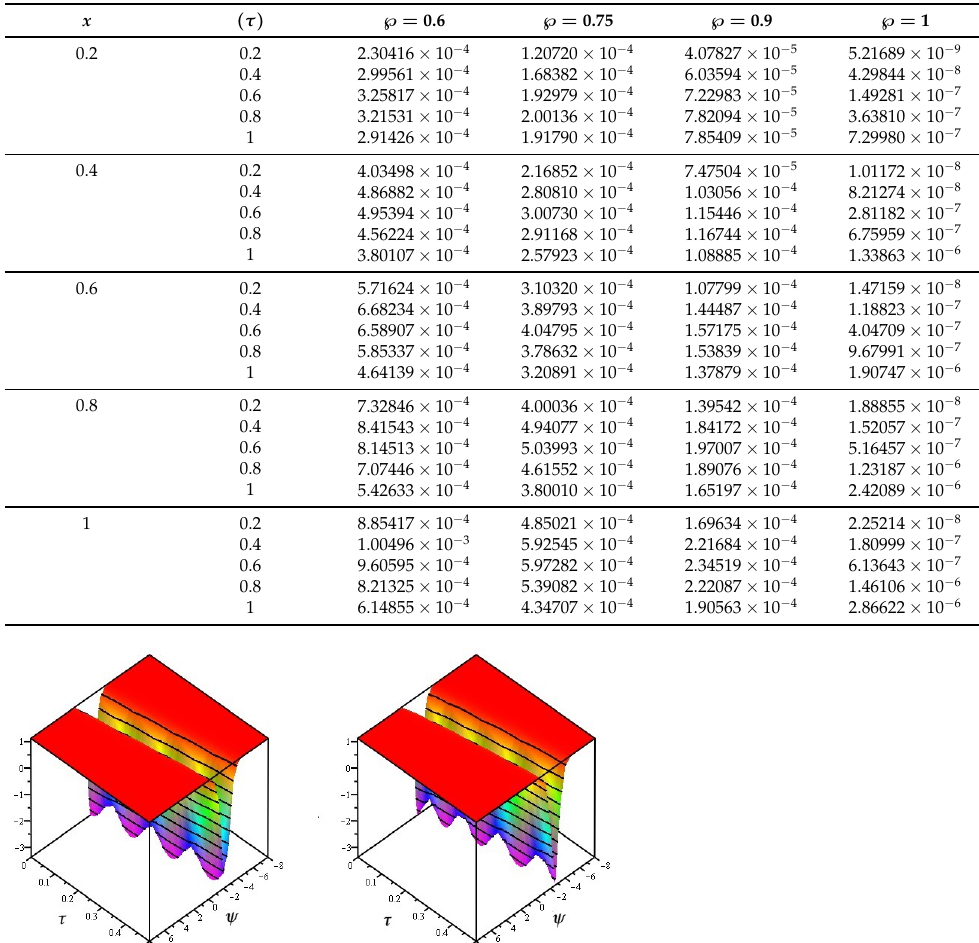
Table 2. The different fractional-order of ℘ at ϕ ( ψ , τ ) Problem 1.